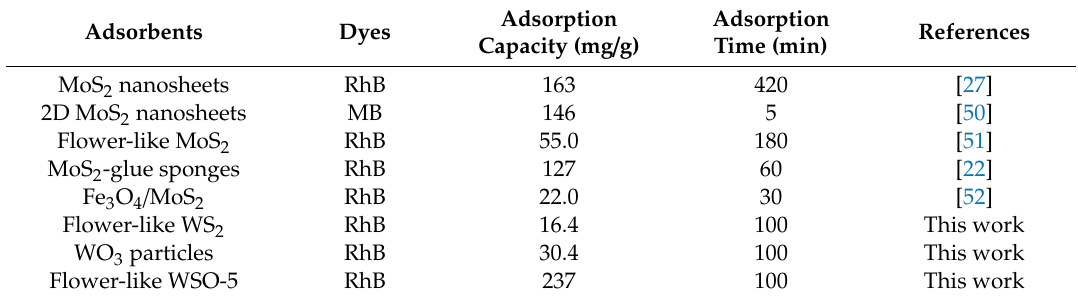
Table 2. A comparison of the adsorption performance of the WS 2 , WO 3 , and WS 2 / WO 3 heterostructures with other reported TMD